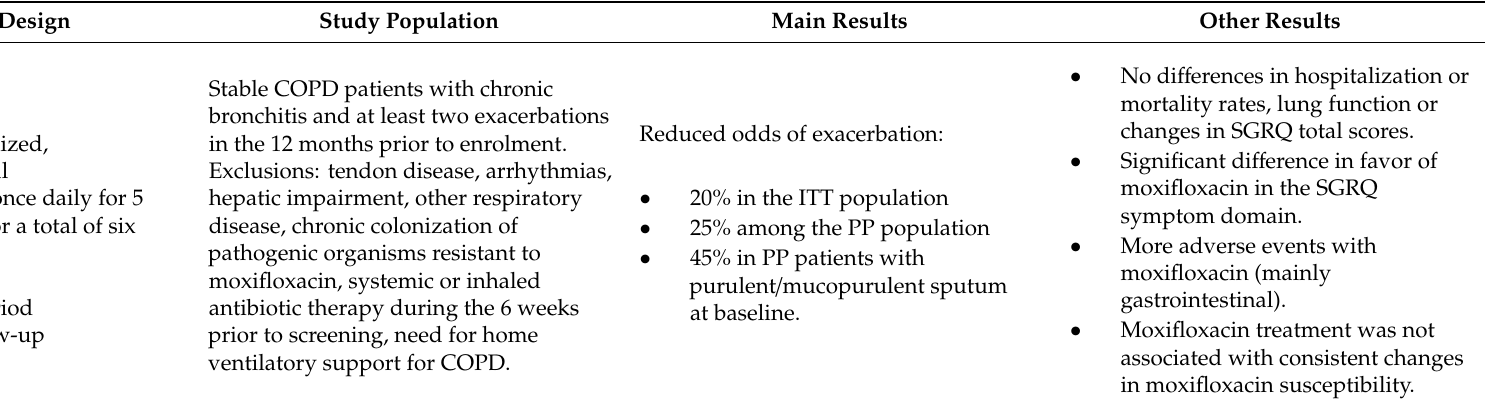
Table 4. Main publications on the long-term use of systemic antibiotics in patients with stable